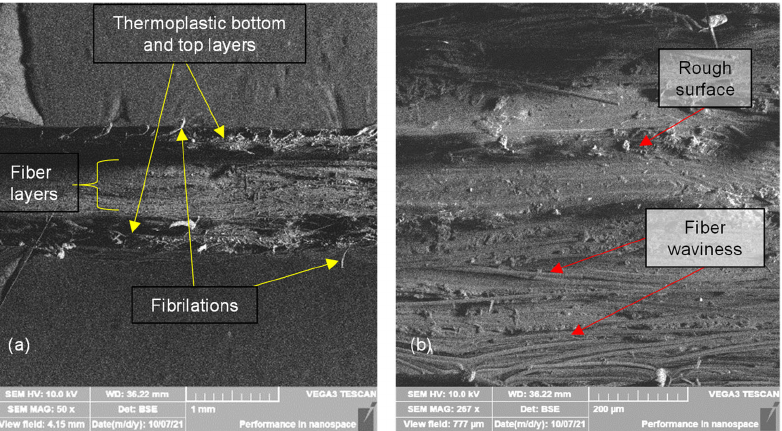
Figure 11. SEM transversal cut of a 55/110 layers carbon fiber on ‐ edge printed sample: ( a ) 50×, ( b ) 267×.